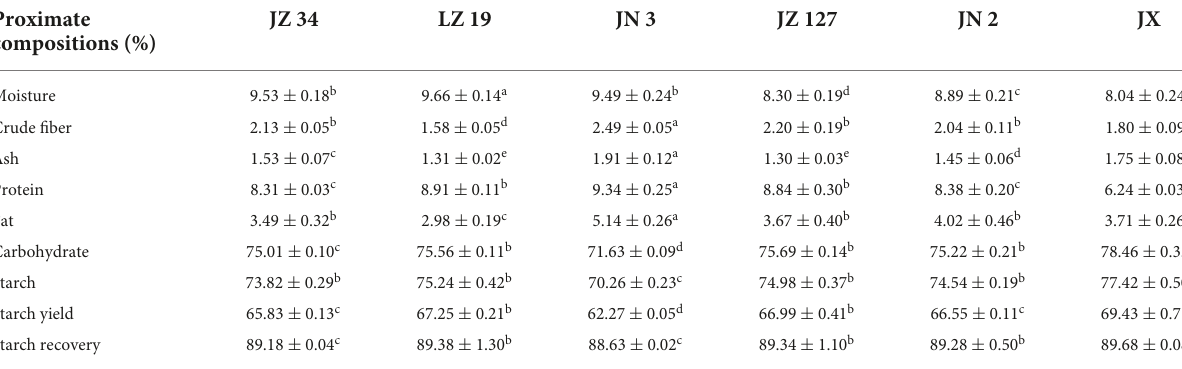
TABLE 3 Proximate compositions of sorghum grains.